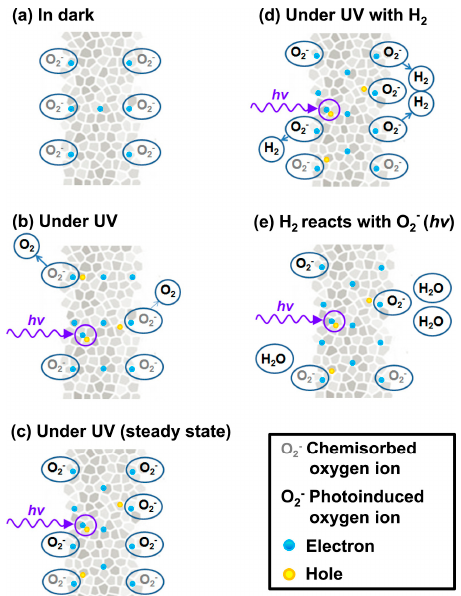
Figure 2. Diagram of the UV-activated room-temperature gas sensing mechanism. Reproduced with permission from [36]. ( a ) In dark; ( b ) Under UV; ( c ) Under UV (steady state); ( d ) Under UV with H 2 ; ( e ) H 2 reacts with O 2 − ( hv ).